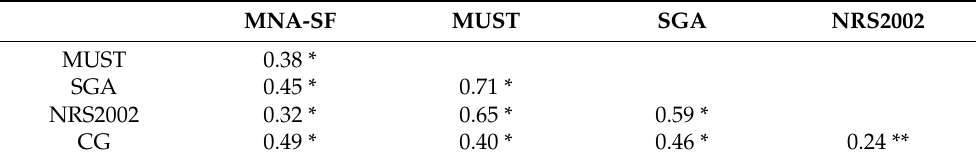
Figure 4. Percentage mean value obtained from each nutritional assessment and screening tool in nursing home elders (MNA-SF—Mini Nutritional Assessment—Short Form; MUST—Malnutrition Universal Screening Tool; SGA—Subjective Global Assessment; NRS 2002—Nutritional Risk Screening 2002; CG—calf girth). Kendall’s tau-b correlation coefficient showed a positive and statistically significant correlation with all the instruments (Table 2). Table 2. Statistical comparison of nutritional assessments and screening tools.